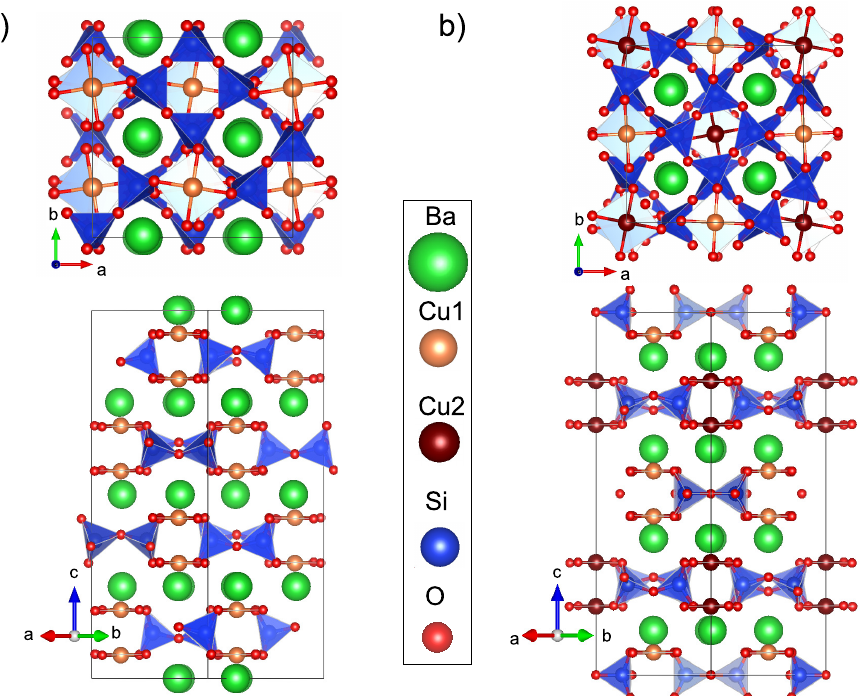
Figure 1. ( a ) Room temperature I 4 1 / acd structure of Han Purple shown along the c -axis and the (1 1 0) direction [10]. ( b ) Same arrangement of the low temperature Ibam structure of Han Purple